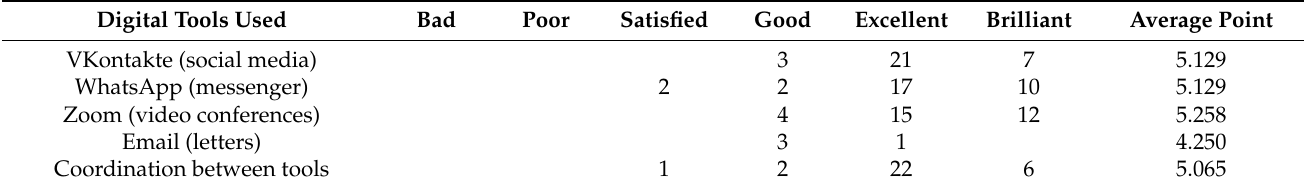
Table A6. Points awarded by students for digital tools applied, September 2020 (N2 = 31).